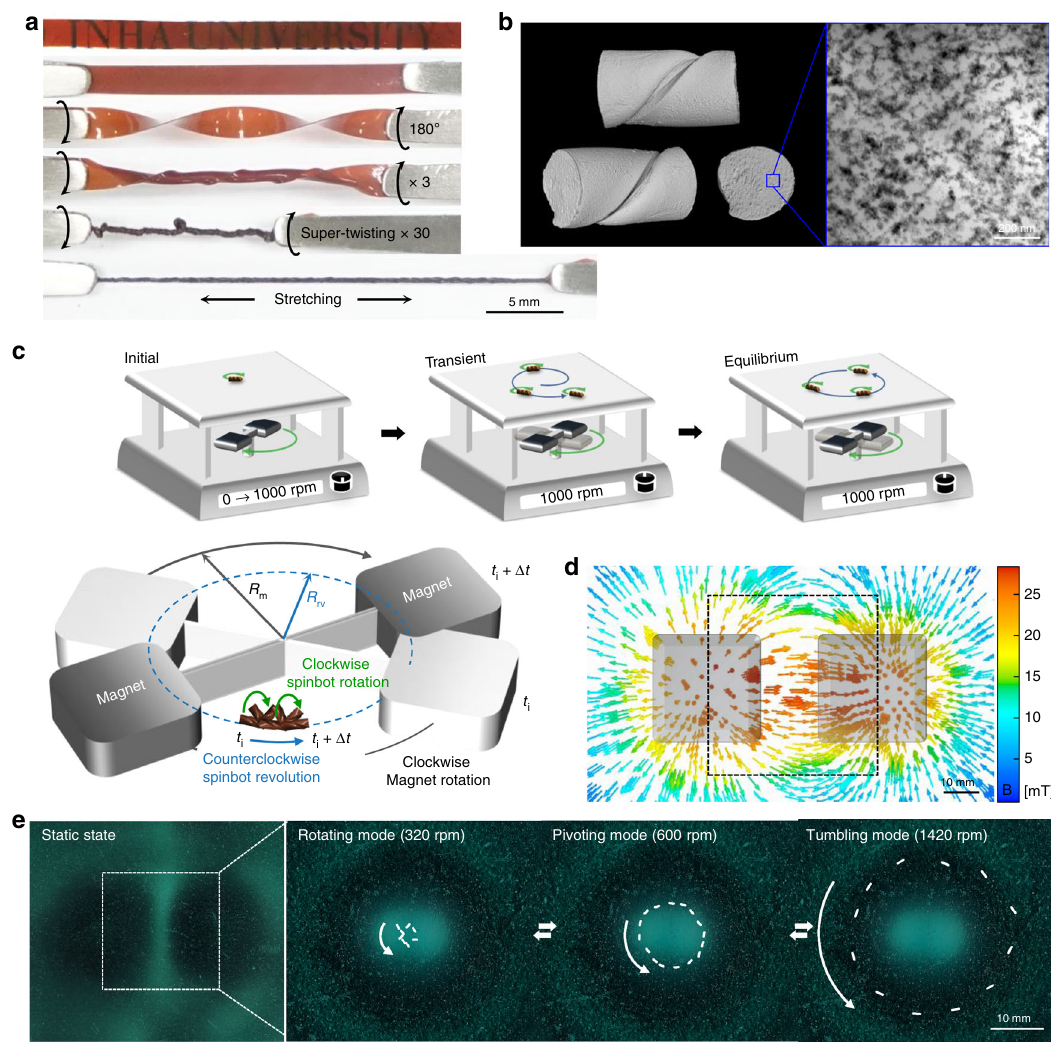
Fig. 1 Facile construction of orbiting spinbots. a Digital image of 3D helical architecture generated from TPU-iron oxide nanocomposite fi lm. b 3D micro-CT image of thermally treated helical nanocomposites (left) and TEM micrograph showing nanoscale dispersion of magnetic nanoparticles in TPU matrix (right). c Orbital maneuver of the spinbots via magnetic rotation. The spinbot rotates once clockwise for each magnetic rotation dependent on time Δ t from initial position at t i , revolving counterclockwise at equilibrium state. d Simulation of magnetic fl ux density involving two ferrite magnets with non-magnetic yoke of the magnetic stirrer. e Reversible control of orbital radius dependent on rotational